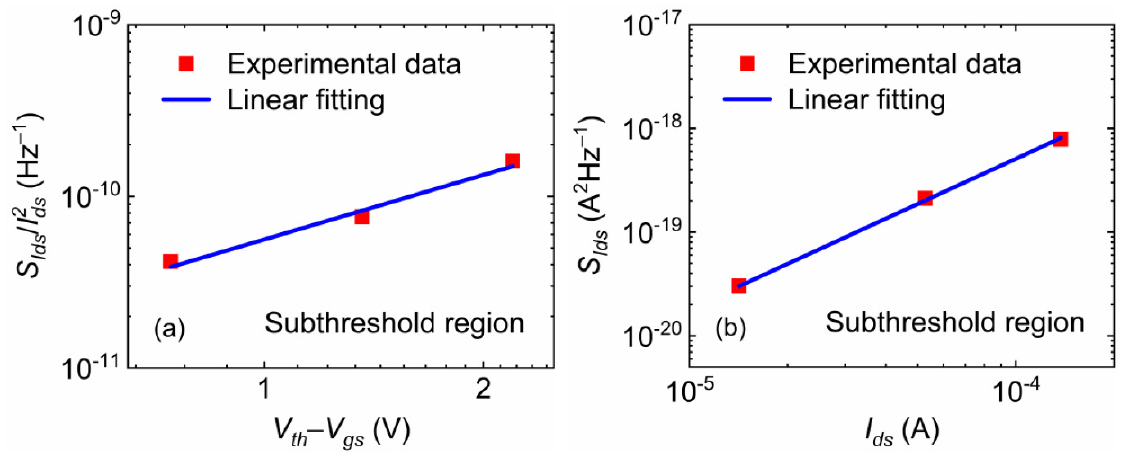
Figure 3. The log–log plots of ( a ) S Ids / I ds 2 versus V th − V gs and ( b ) S Ids versus I ds in the subthresh- old region.